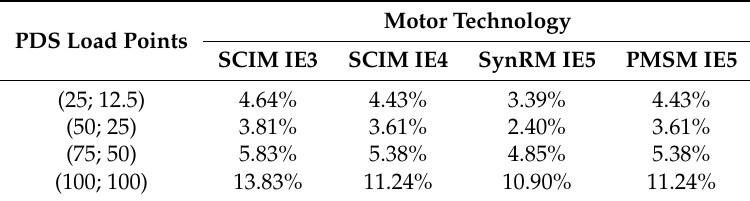
Table 4. PDS losses for four di ff erent motor technologies and four di ff erent load